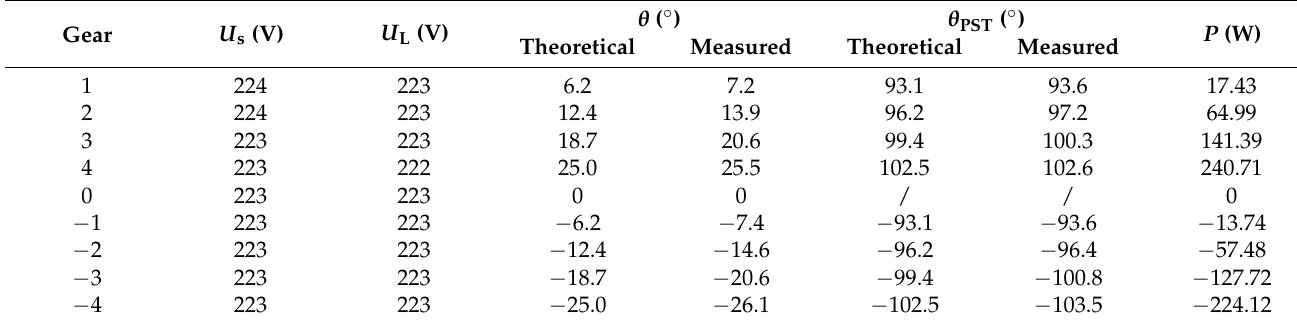
Figure 19. Experimental wiring diagram. Table 4. Experimental test